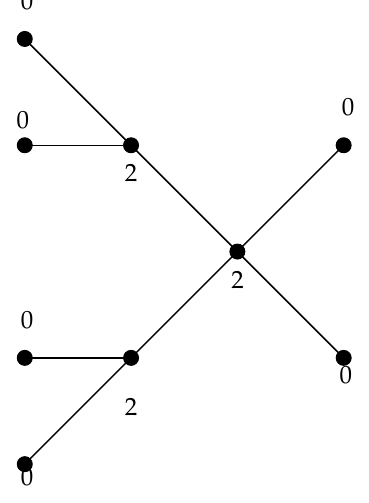
( T ) -function of a tree T Figure 1. γ P R